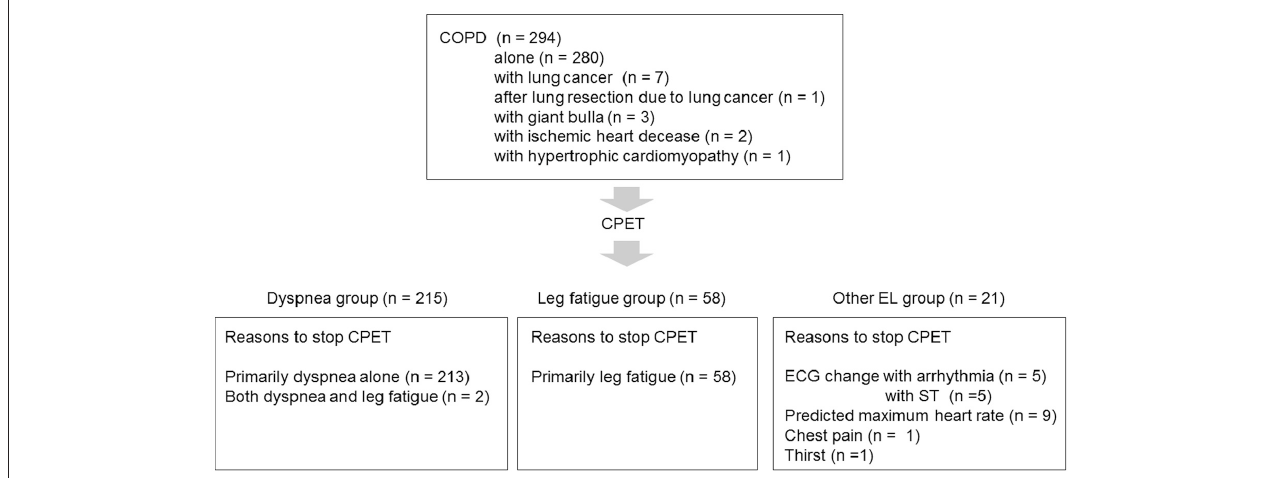
FIGURE 2 | Patient selection flowchart COPD, chronic obstructive pulmonary disease; CPET, cardiopulmonary exercise testing; ECG, electrocardiogram; EL, exercise